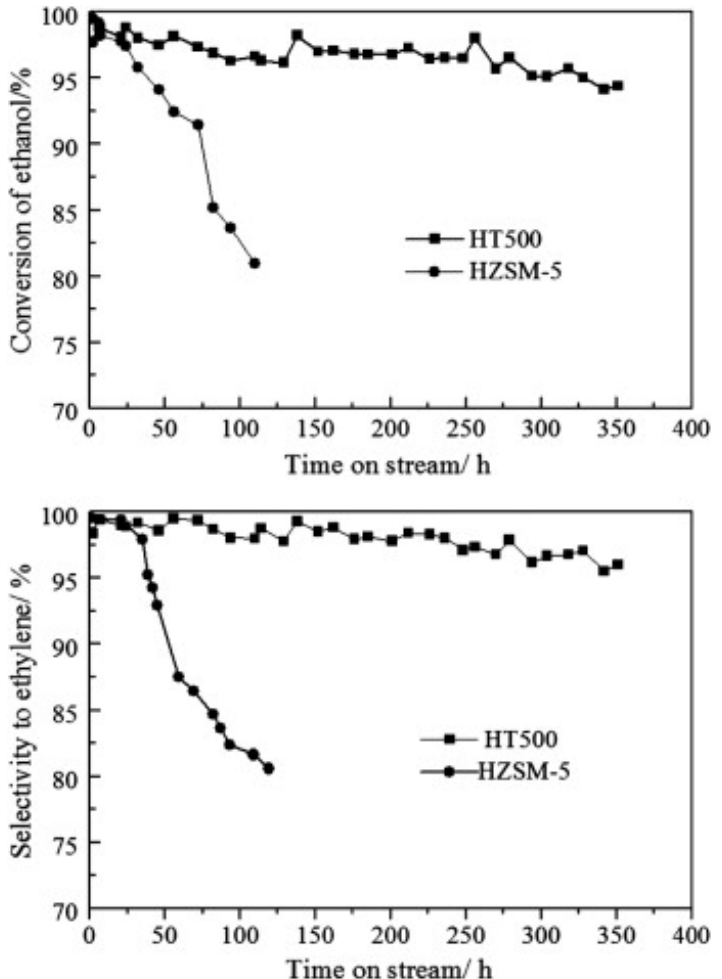
Figure 10. Ethanol dehydration catalytic activities of the steam treated (HT500) and parent (HZSM-5) ZSM-5 zeolites. Reprinted with permission from [38]. Copyright 2012 Elsevier B.V.